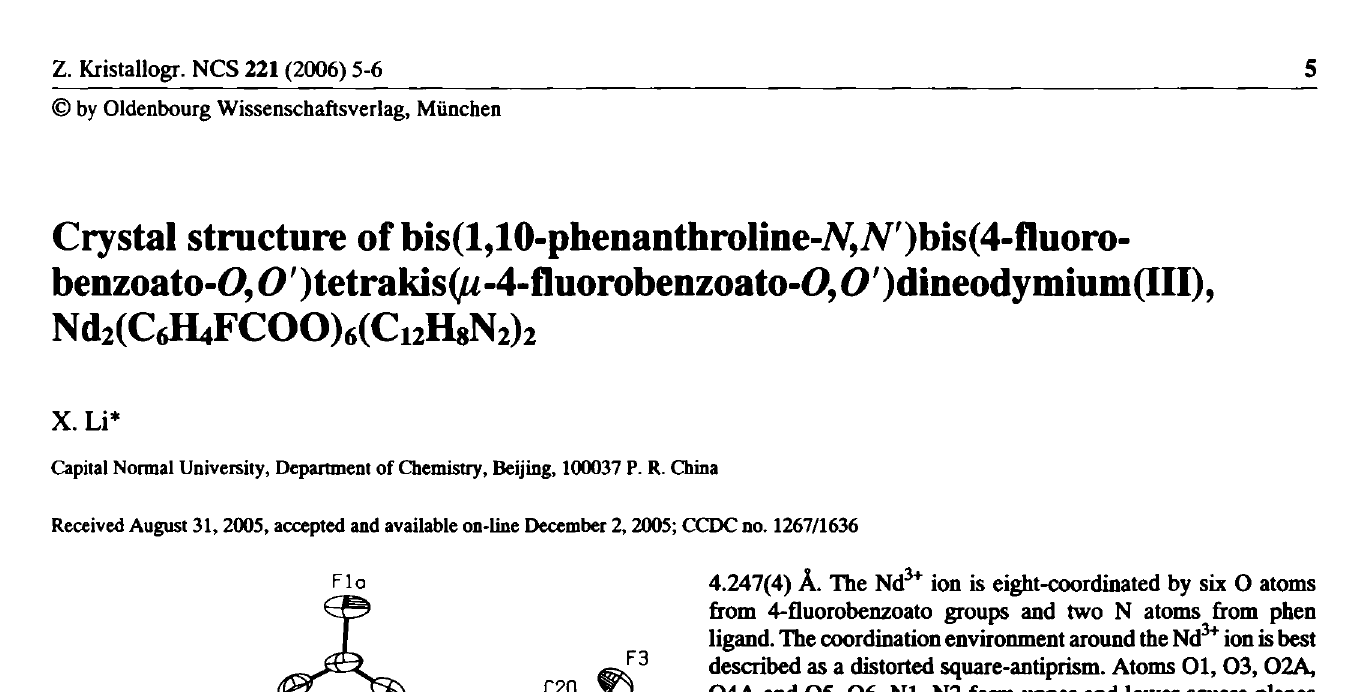
Table 1. Data collection and handling.